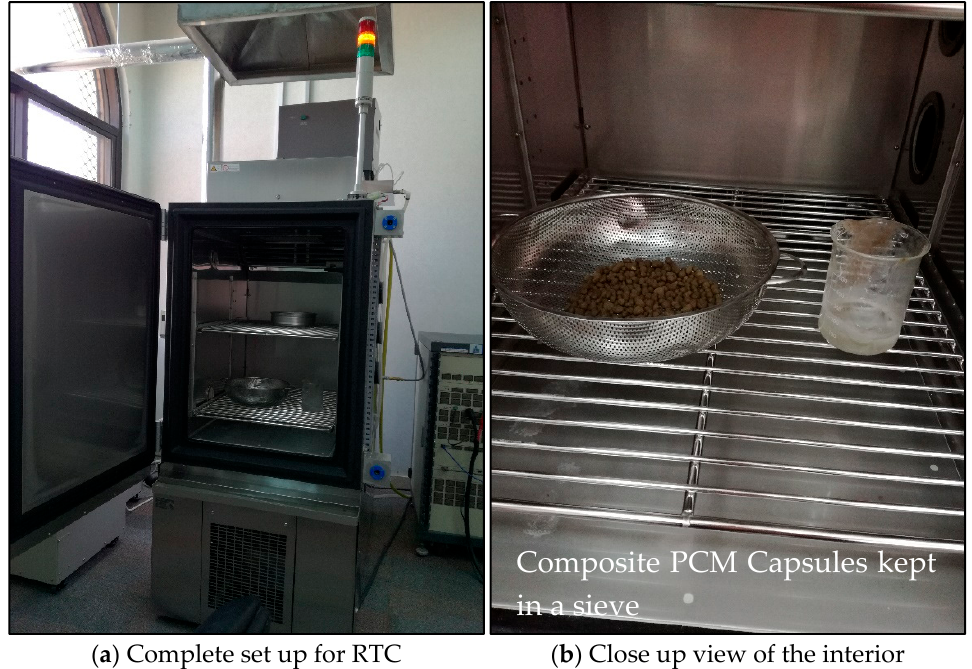
Figure 6. Set-up used for rapid thermal cycling: ( a ) complete view, and ( b ) a photo of the inside chamber.